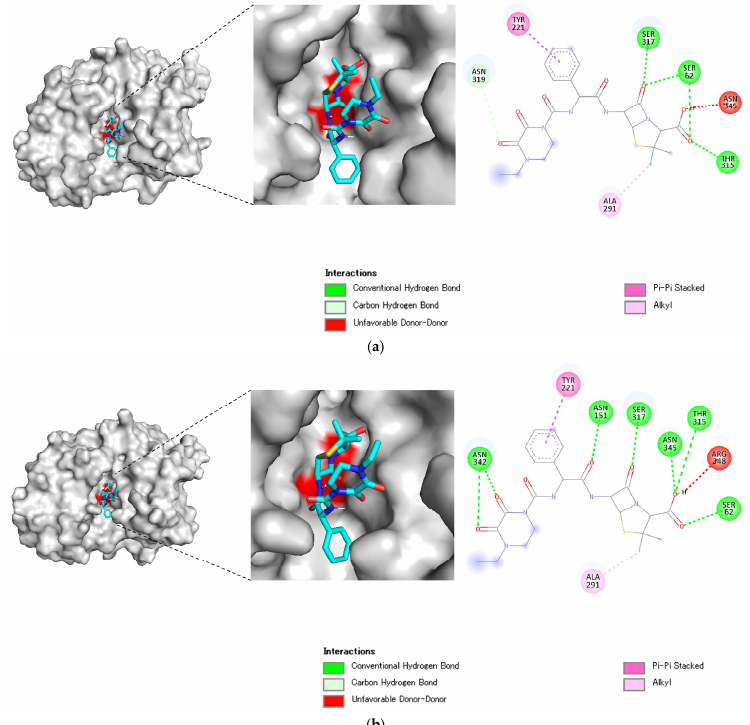
Figure 4. Structural model-based binding between piperacillin and representative PDC from clusters ( a ) A and ( b ) H. The three-dimensional (3D) structures of piperacillin are presented as stick models. The active sites on the protein surface are indicated in red. 4. Discussion Sequence polymorphism of PDC has generated increasing concern [34,35]. To eluci- date the molecular evolution of bla PDC , we investigated this using bla PDC gene samples from various parts of the world. Based on the bla PDC gene clusters revealed by this analysis, we conducted a docking simulation between PDC and piperacillin to elucidate their molecu-